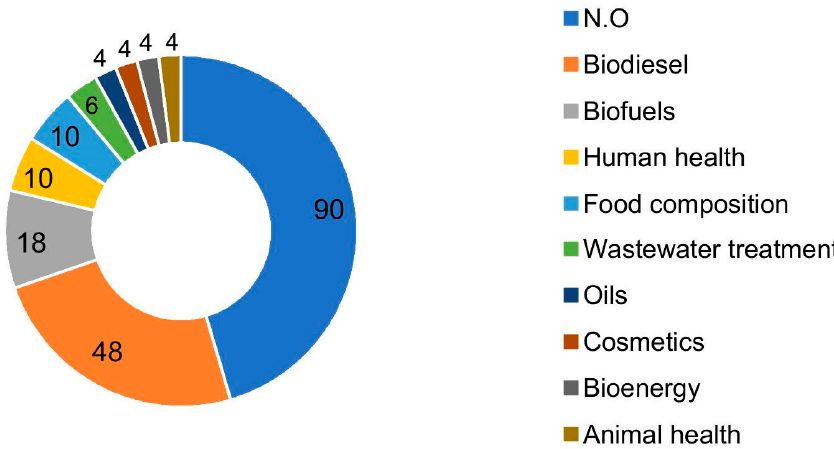
Figure 4. Number of documents by applications. “N.O” refers to unspecified.